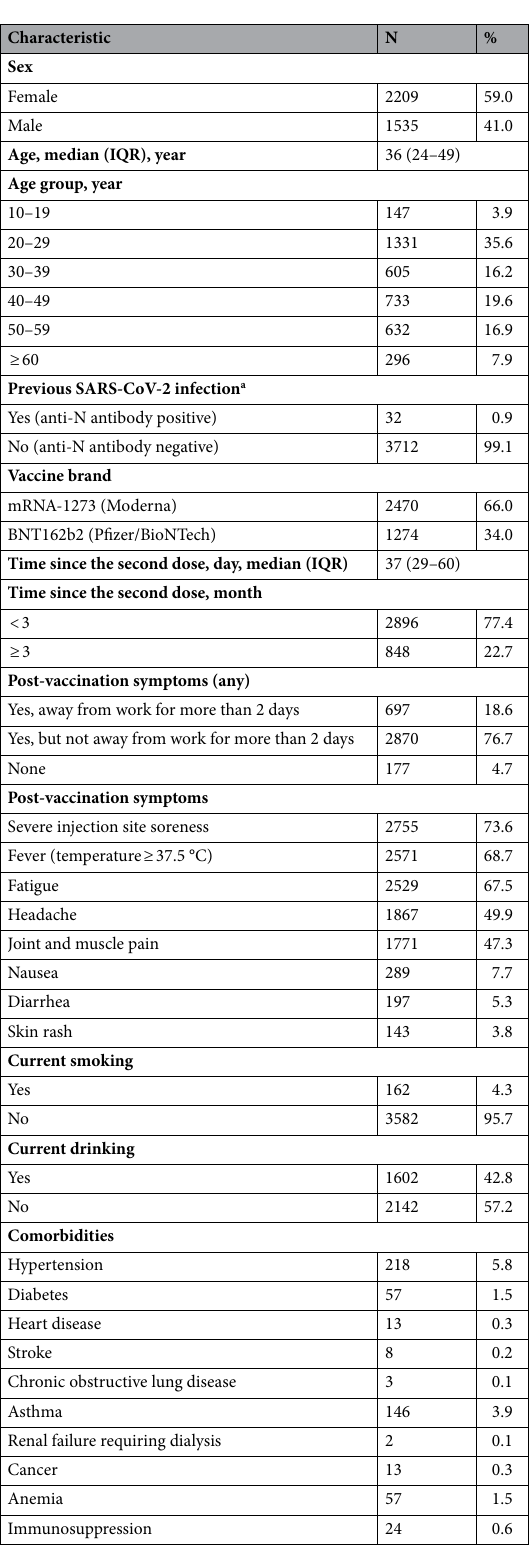
Table 1. Demographic characteristics of the study participants (N = 3744). SAR-CoV-2 severe acute respiratory syndrome coronavirus 2. a Previous SARS-CoV-2 infection was defined anti-SARS-CoV-2 Nucleocapsid (N) IgG antibody